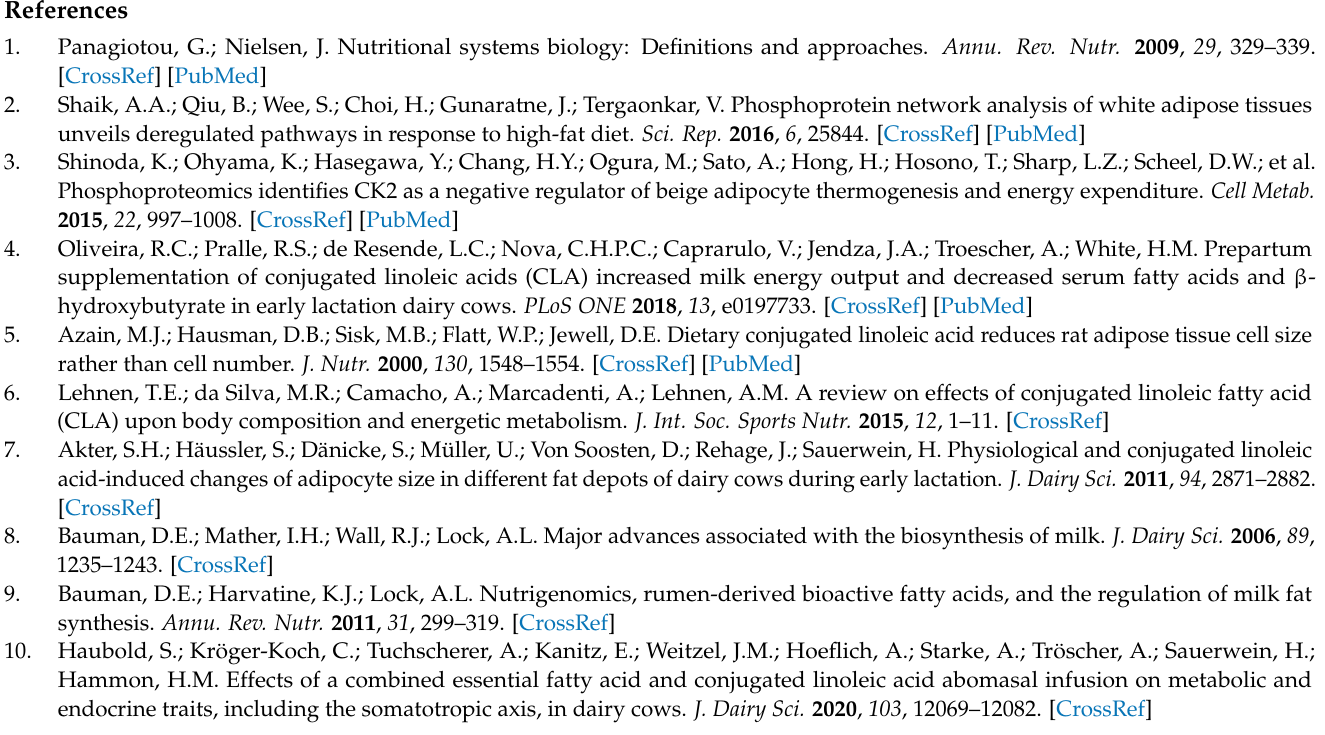
dairy cows, Table S3: List of primers used for mRNA expression in CON vs. CLA AT, Table S4: Immunoblot abundance of lipid-metabolism proteins in SC and OM AT of CLA vs. CON cows, Table S5: Amounts of daily abomasally infused supplements to dairy cows supplemented either with coconut oil (CON; n = 5) or conjugated linoleic acid (CLA; n = 5) from d 63 antepartum until slaughter on d 63 postpartum, Table S6: Ingredients and chemical compositions of the diets provided to cows abomasally supplemented either with coconut oil (CON; n = 5) or conjugated linoleic